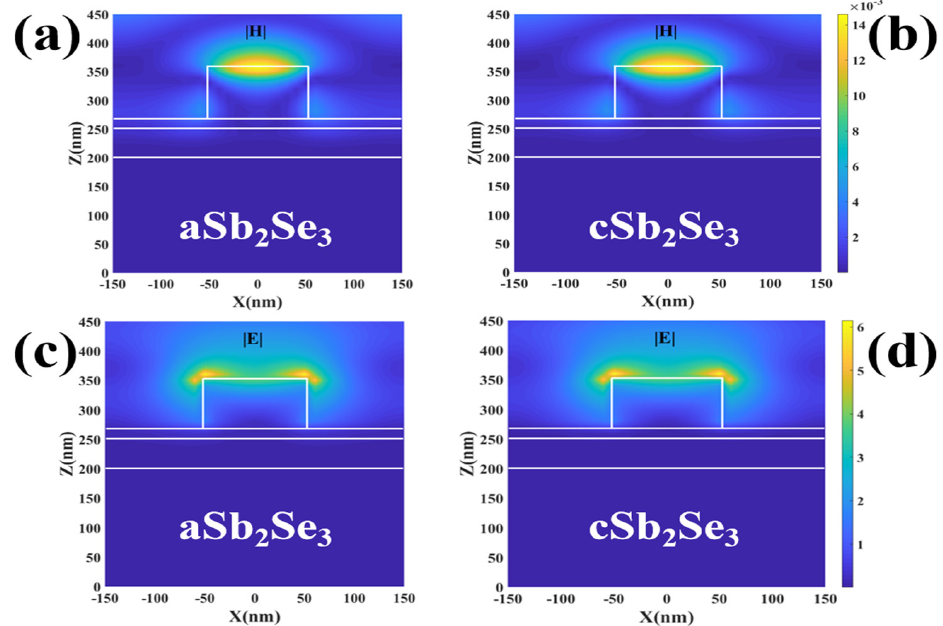
Figure 3. ( a , b ) Magnetic field distribution diagrams under the amorphous and crystalline states; ( c , d ) electric field distribution under the amorphous and crystalline states.